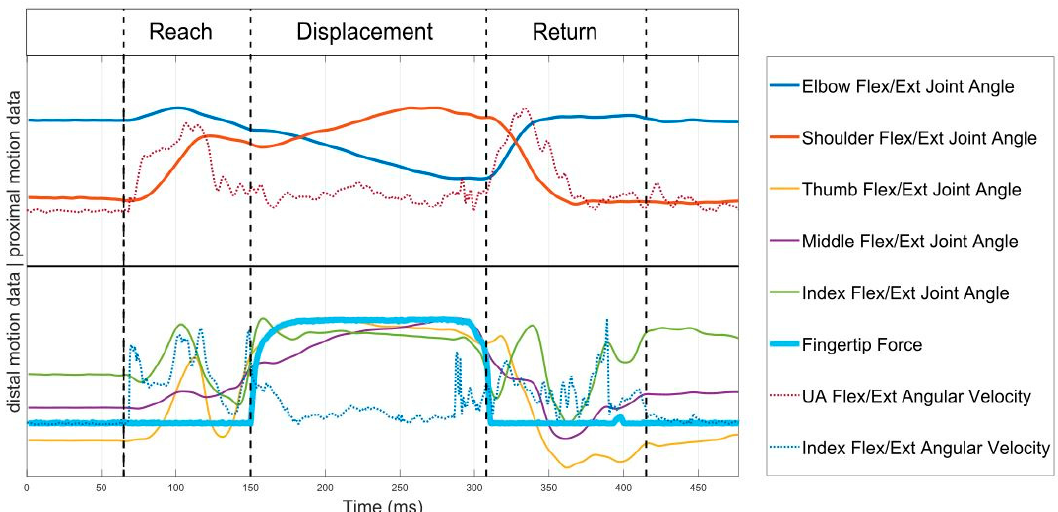
Figure 3. Proximal (shoulder, elbow), distal (finger) motion data and force signal for phase segmentation. The data is scaled to fit the plot, not the actual measured values on the y -axis.